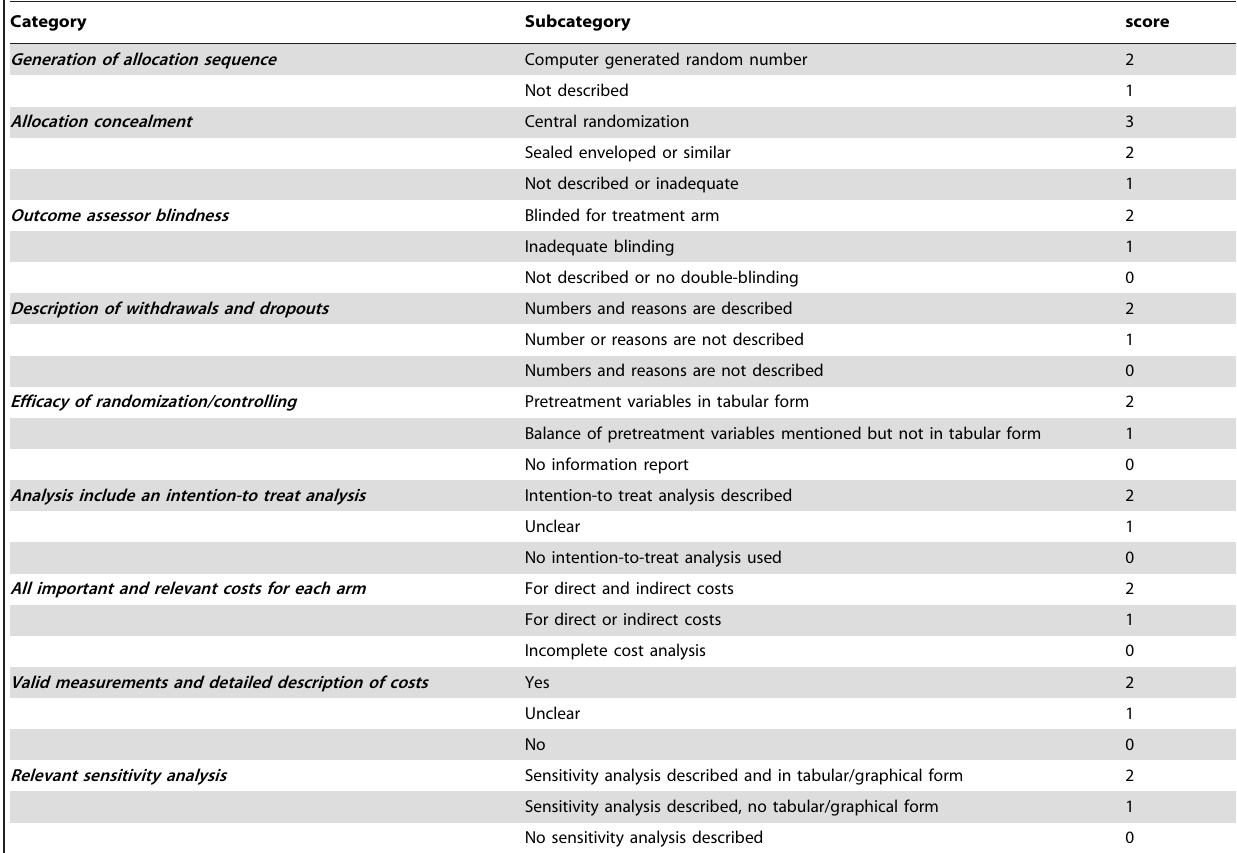
Table 1. Methodological quality